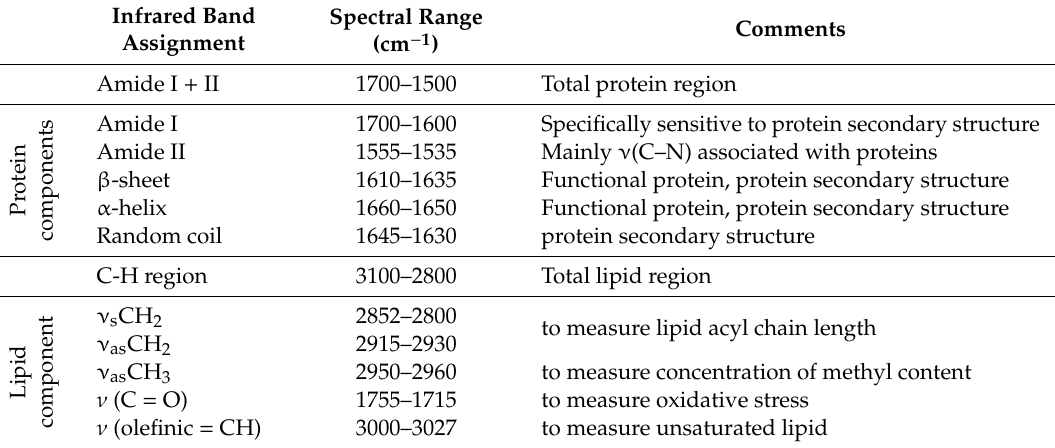
Table 1. Spectral regions used for analytical interpretation for Stroke